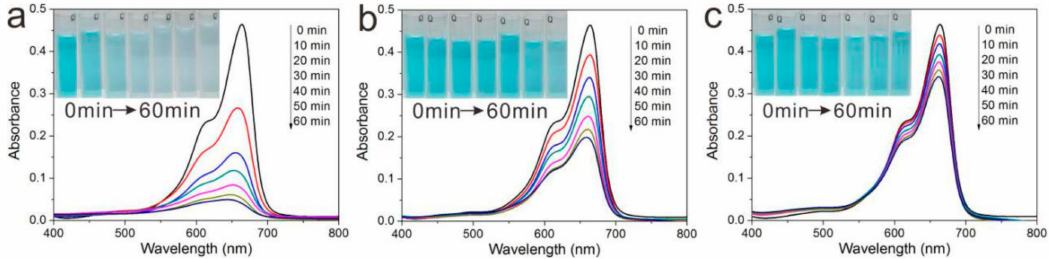
Figure 10. Time-dependent UV-vis spectra for the photodegradation of MB in the presence of TiO 2 nanoparticles under no protection ( a ) and protected by FPI with 0.05 mm thick ( b ), FPI / FHBPI-15% with 0.05 mm thick ( c ). The inserted photographs show the corresponding changes in MB solutions in